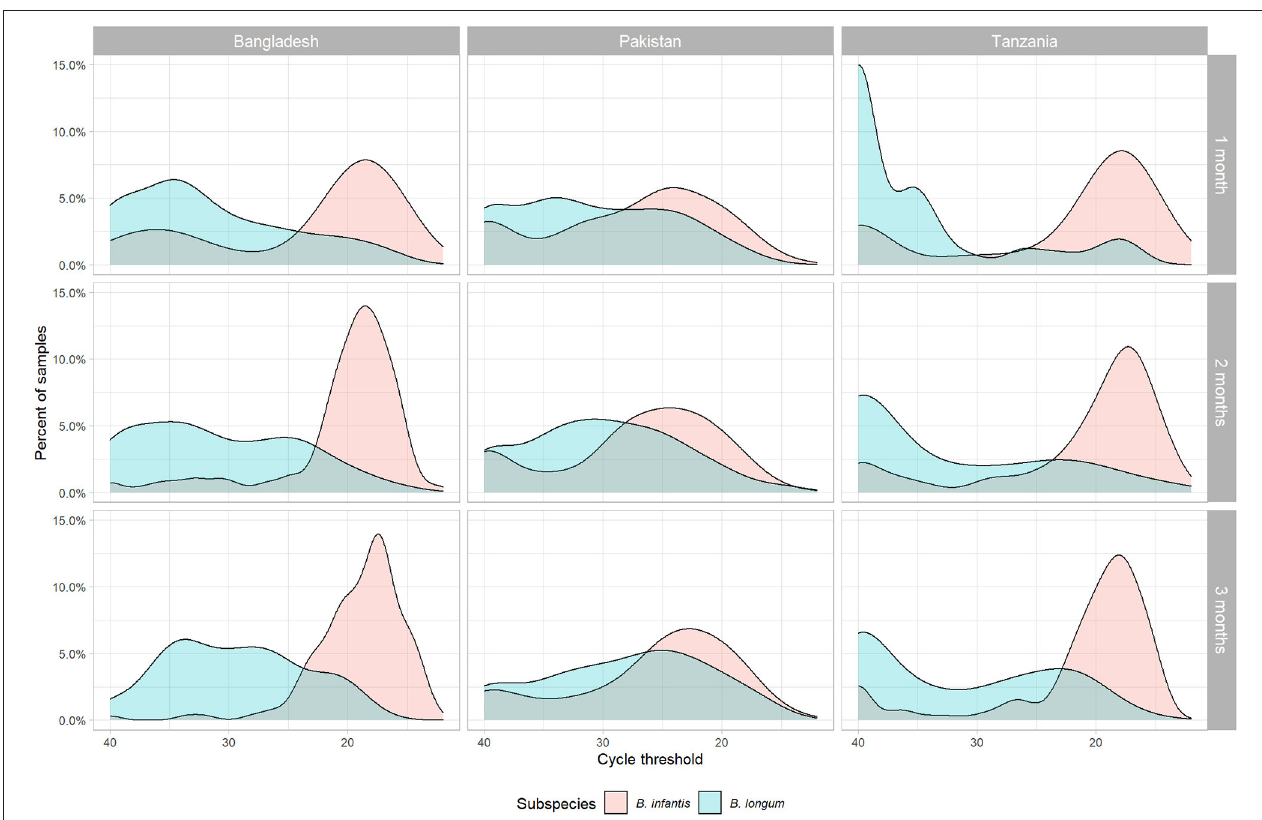
FIGURE 1 | Density distribution of cycle threshold values for two subspecies of Bifidobacterium longum ( infantis and longum ) measured by PCR in stool samples by subspecies, site, and month of